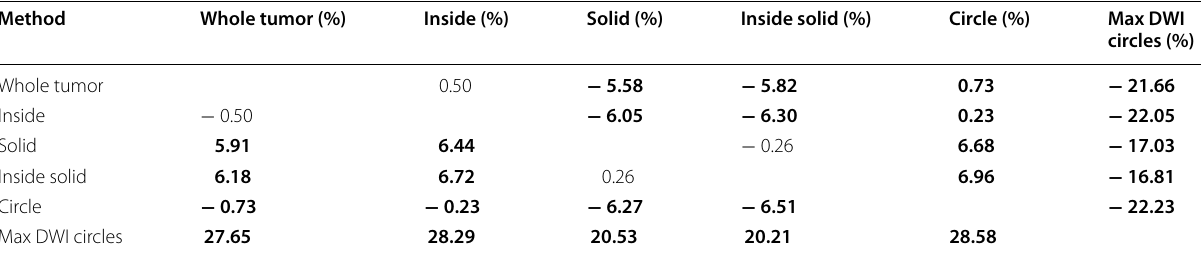
Bold numbers indicate significantly different distributions as determined by the two-sample Kolmogorov–Smirnov test. Excluding the edge from an ROI yields no significant differences in the distribution. All other methods do yield different distributions